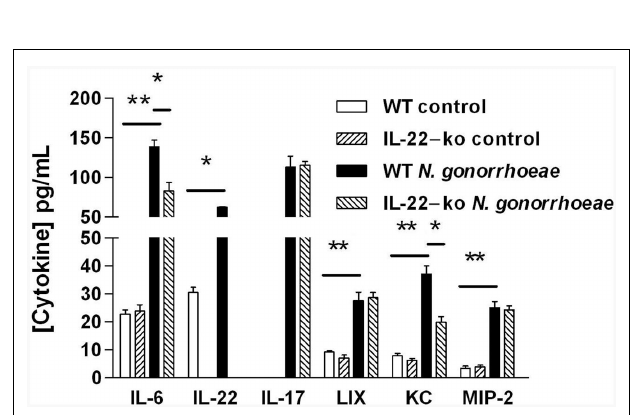
FIGURE 2 | Production of cytokines and chemokines by mouse vaginal explants cultured with N. gonorrhoeae . Vaginal tissue fromWT or IL-22-ko mice was incubated in vitro in medium only (control) or with N. gonorrhoeae at a concentration of 2 × 10 7 CFU/ml. Supernatants were assayed after 3days for cytokines and chemokines by ELISA. Results are shown as mean ± SD of triplicate cultures. Cytokine or chemokine production byWT tissue in the presence of N. gonorrhoeae was significantly higher than in corresponding controls, or than by IL-22-ko tissue in the presence of N. gonorrhoeae , as indicated by the bars: ** P < 0.01; * P < 0.05 (Student’s t ).